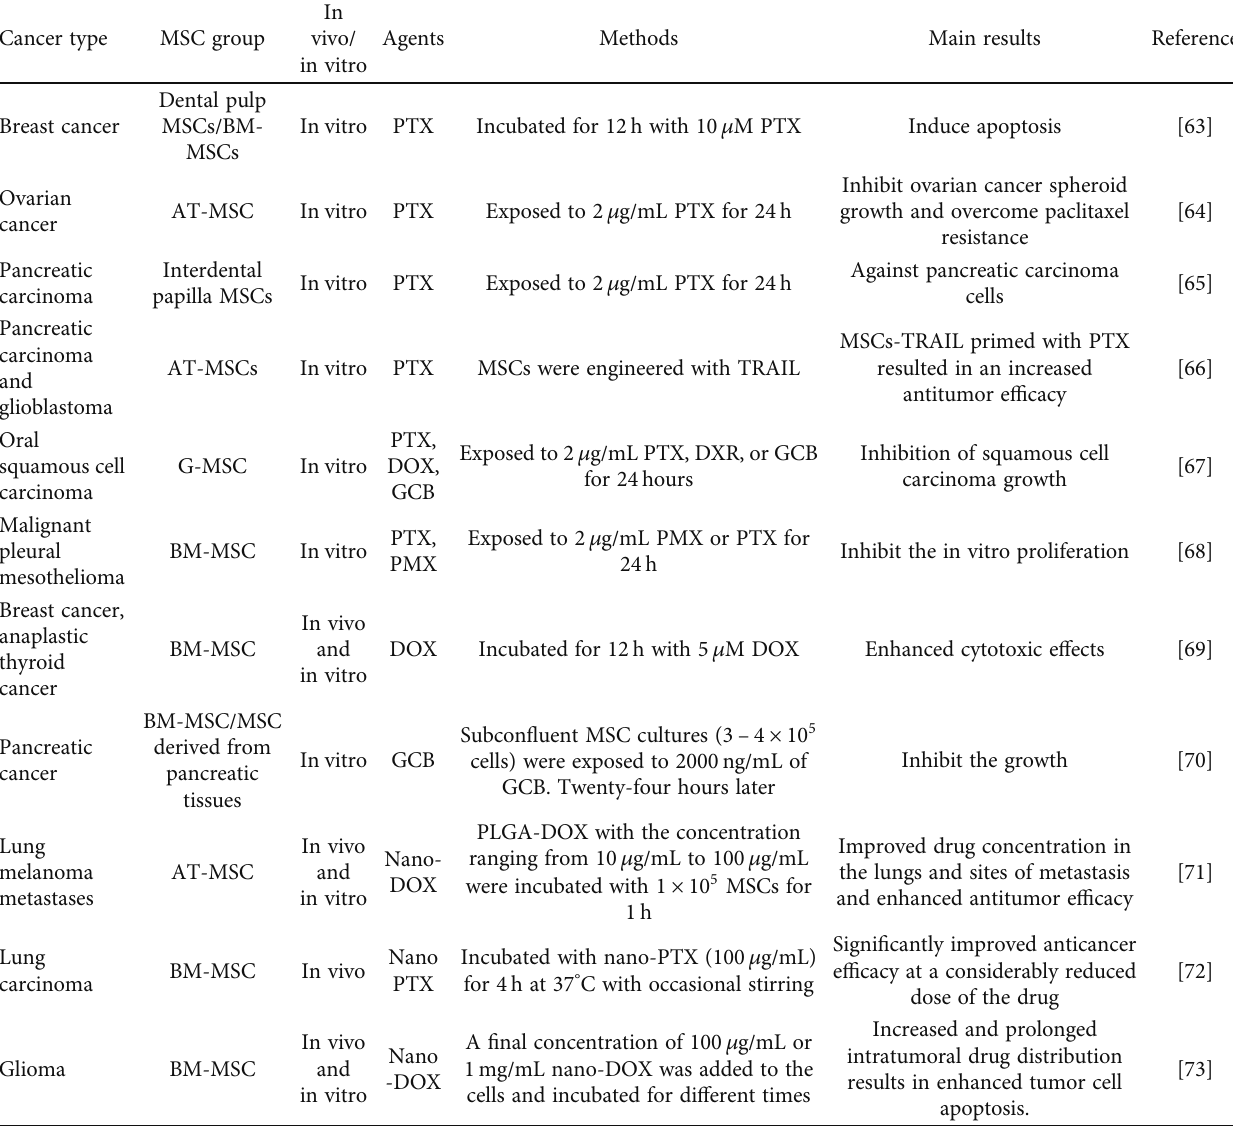
Table 3: MSC as delivery of chemotherapeutic